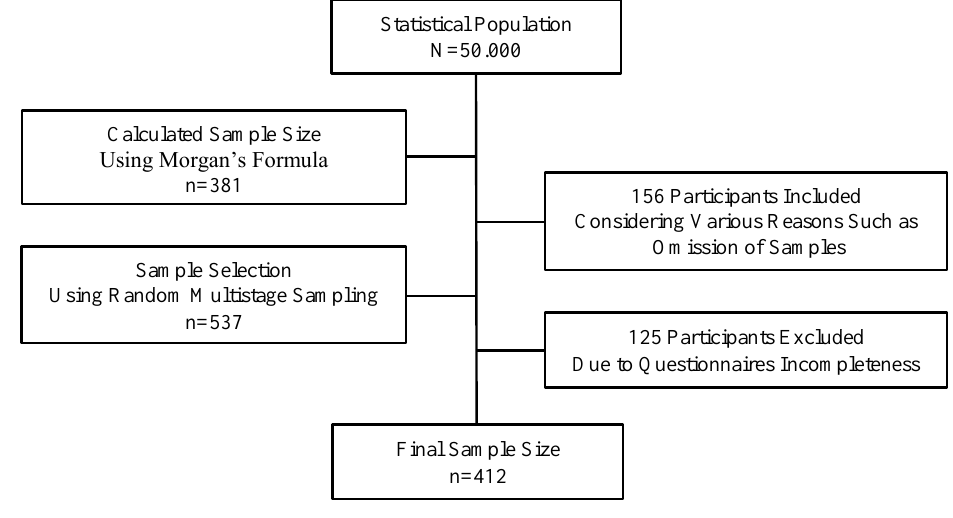
Figure 1. Participant Flow